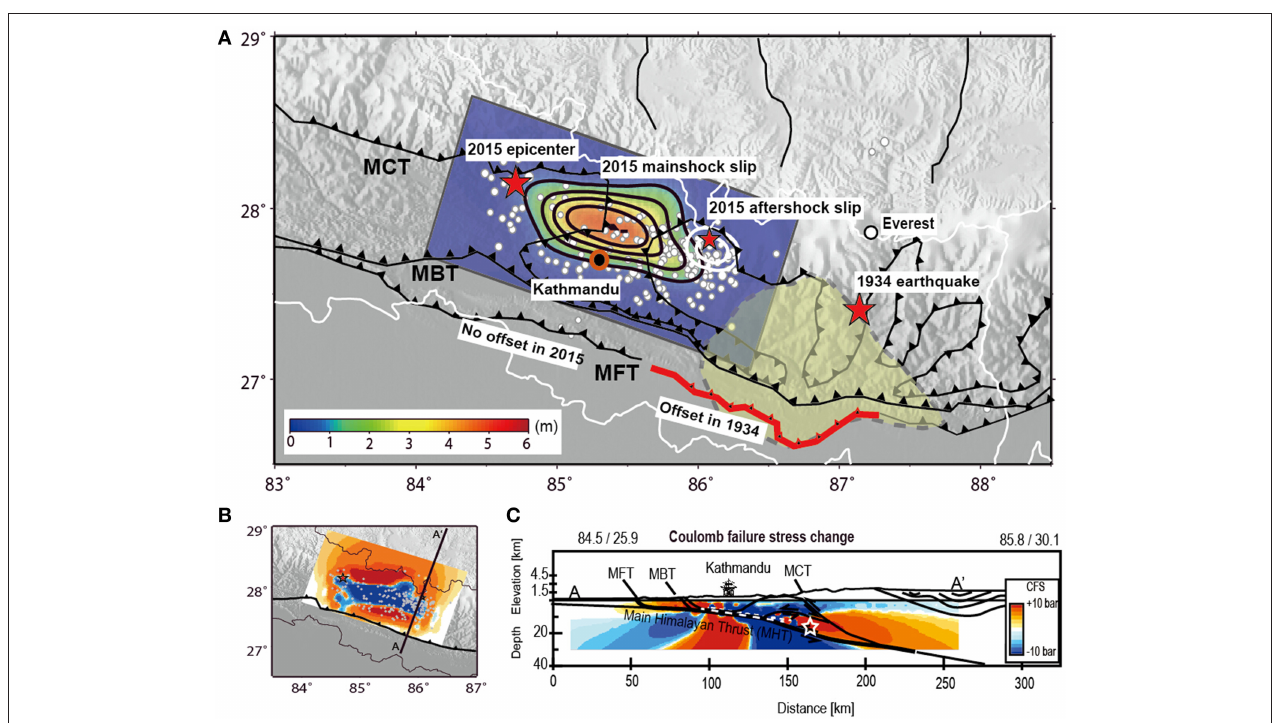
FIGURE 5 | (A) Synthesis map. Red stars: great Himalayan earthquakes, in 1934 the Mw 8.2 Bihar earthquake, and in 2015 the Gorkha earthquake, white dots: earthquake aftershocks. The main fault displacement locates just to the north of Kathmandu (shown by red circle), where amount of slip is color coded and peaks at ∼ 5.2m (color and black contours with interval of 1m). The largest aftershock is located just to the east of the slip area and peaks at 2.5m (white contours with interval of 1m). InSAR data from three different satellites could not reveal any coseismic rupture associated with any of the main thrusts (MFT, MBT, MCT). This contrasts to the interpretation of the 1934 earthquake, where significant displacement at the MFT was inferred ( Sapkota et al., 2013). (B) Coulomb failure stress (CFS) on the main rupture plane. The CFS has decreased at the slip area, and increased in the surrounding. (C) Cross section with the main fault lines (Avouac et al., 2001) and CFS calculated by the coseismic mainshock slip model, where red denotes a stress built up, and blue a stress shadow. The updip and downdip areas receive large CFS built up. Note that the downdip area has experienced the largest aftershock (white star), whilst the updip region so far did not display any rupture. This figure is drawn using GMT